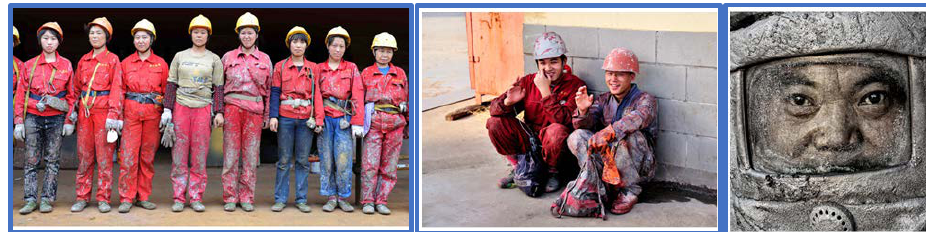
Figure 1. Current situation of painting workers in Chinese shipyards.